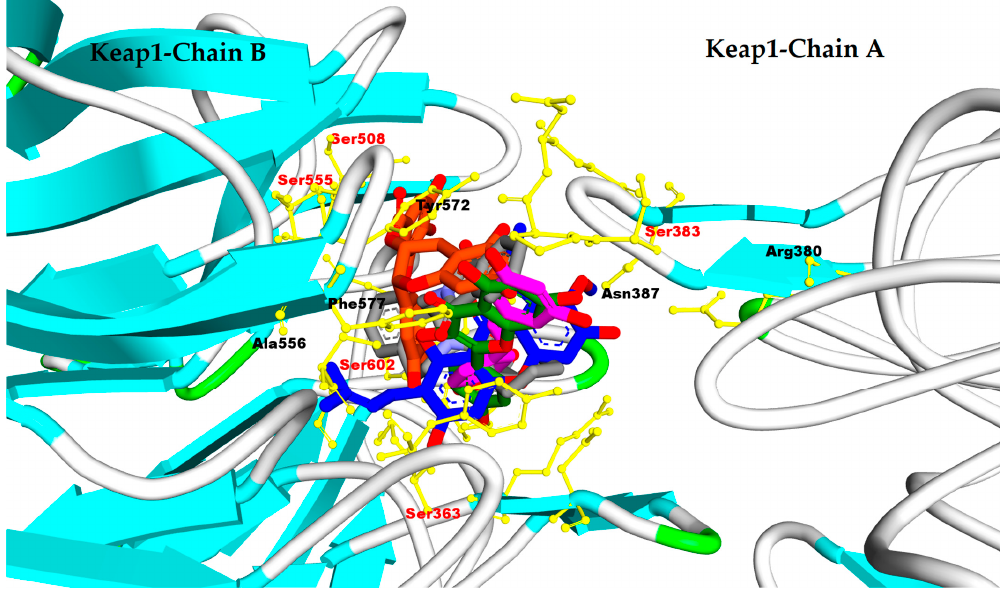
Figure 11. Pose of AM, kaempferol, EGCG, apigenin, and resveratrol against the binding site of Keap1. (Grey carbon: native ligand (green carbon: native ligand, blue carbon: AM, green carbon: kaempferol, pink carbon: resveratrol, and orange carbon: EGCG, yellow atoms: amino acid residues that have interactions with hydrophobic moiety of ligands).